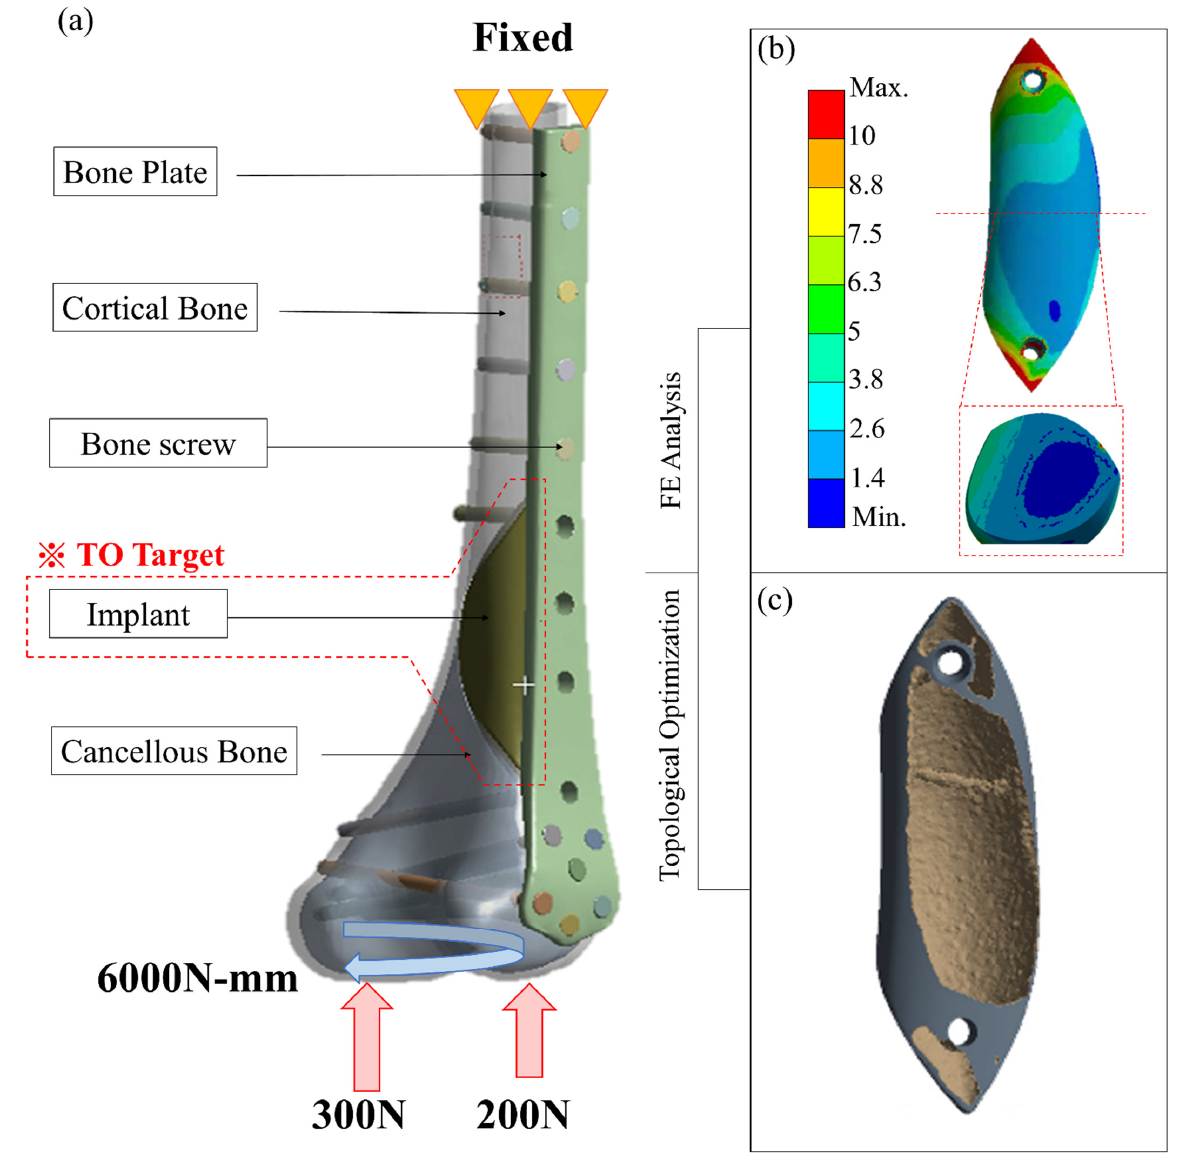
Figure 4. ( a ) Loading, boundary conditions, and material distribution of FE analysis for distal